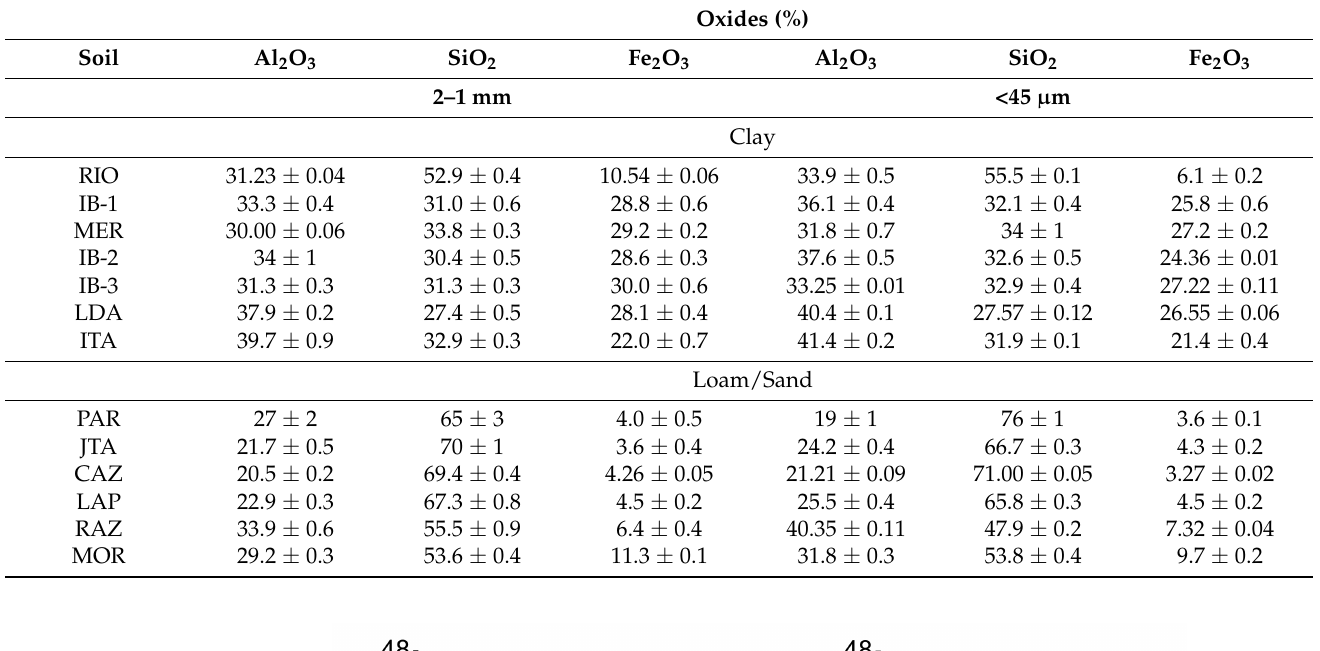
Table 2. Main oxides measured in the 13 soil types studied with different aggregate sizes (2–1 mm and <45 µ m). The average values are followed by the standard deviation, which was rounded according to significant figures.